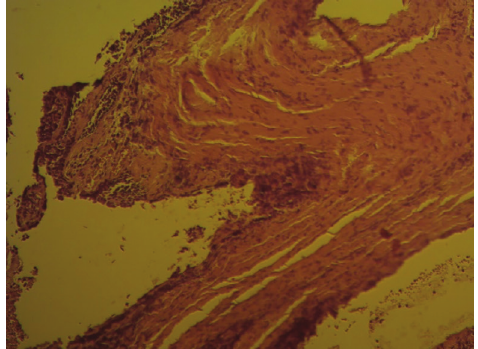
Figure 1.1 - Ultrasound of parameatal cyst. An isoechoic cystic lesion anterior to the urethral orifice